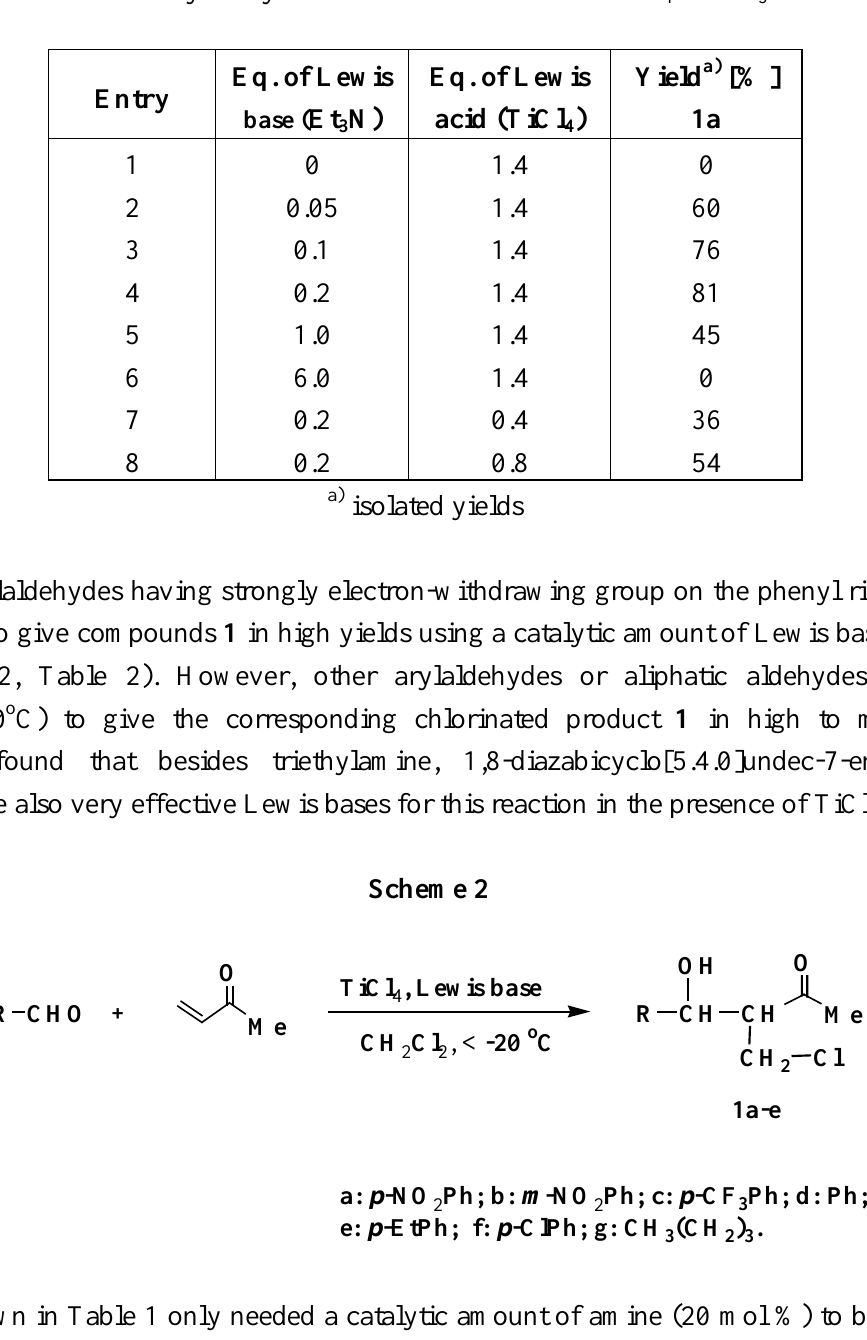
Table 1. Reaction Conditions for the Bayliss-Hillman Reaction of